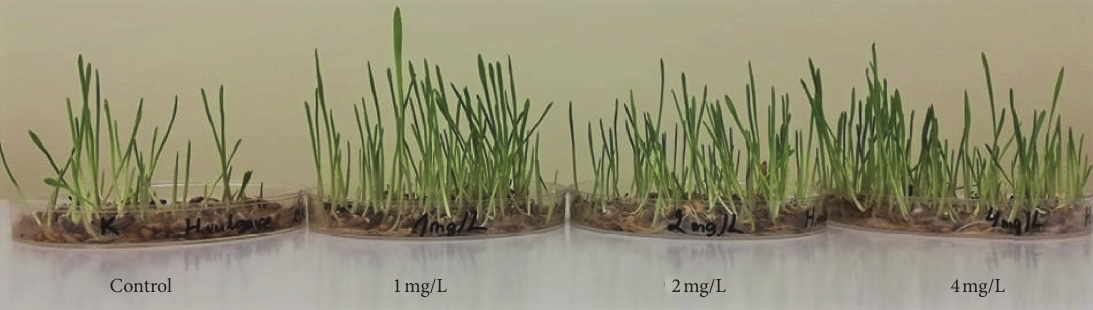
Figure 2: Germinated barley seedling growth under ZnO NPs stress conditions on the 7th day of